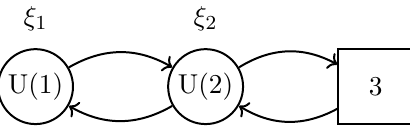
Figure 23 . Quiver of T (SU(3)) theory. ξ i is the FI parameter relative to the i -node. parameters ξ , ξ , associated with the U(1) and U(2) gauge groups respectively, and the real 1 2 masses for the SU(3) symmetry m F